Question: Sum up the contents of this chart in one sentence.
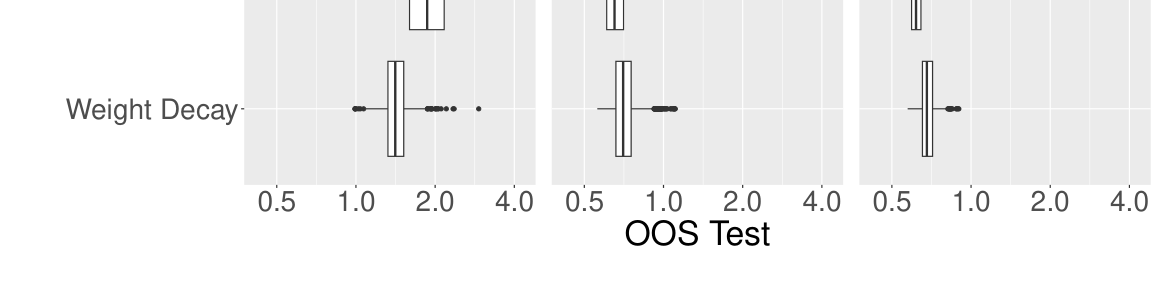
Answer: Boxplots of out-of-sample mean squared error evaluated on a test data set (on a logarithmic scale) for the models selected using the proposed approach, the full model, the full model with early stopping, and the full model with weight decay.